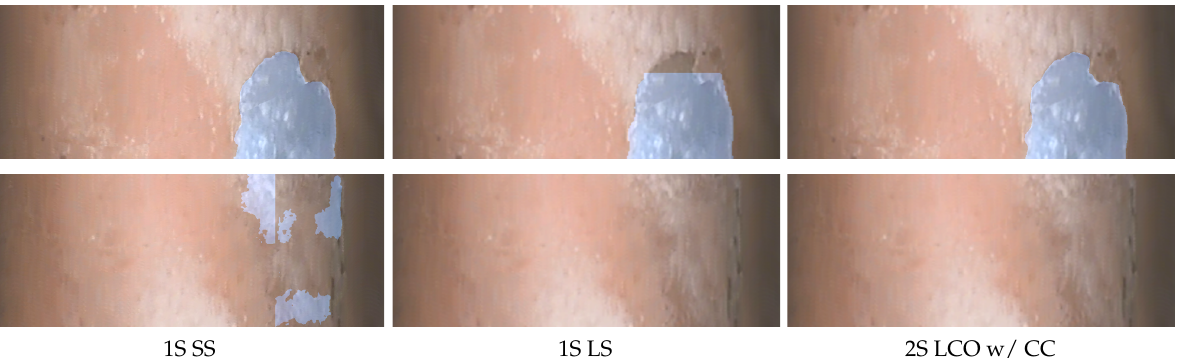
Figure 9. Example segmentation results on two parts of one overview image from the test dataset ( top and bottom ). The applied networks are all from the same iteration. The final binary segmentation mask of each method is visualized with a blue